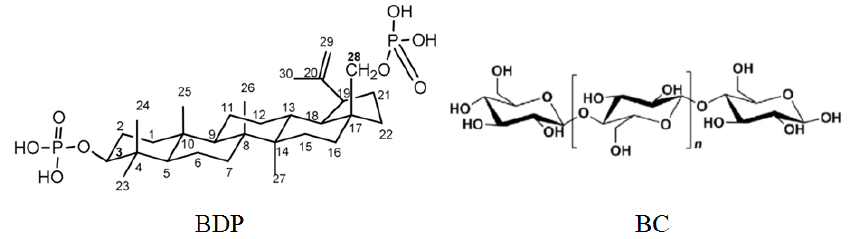
Figure 8. Formulas of betulin-3,28-diphosphate (BDP) and cellulose unit.